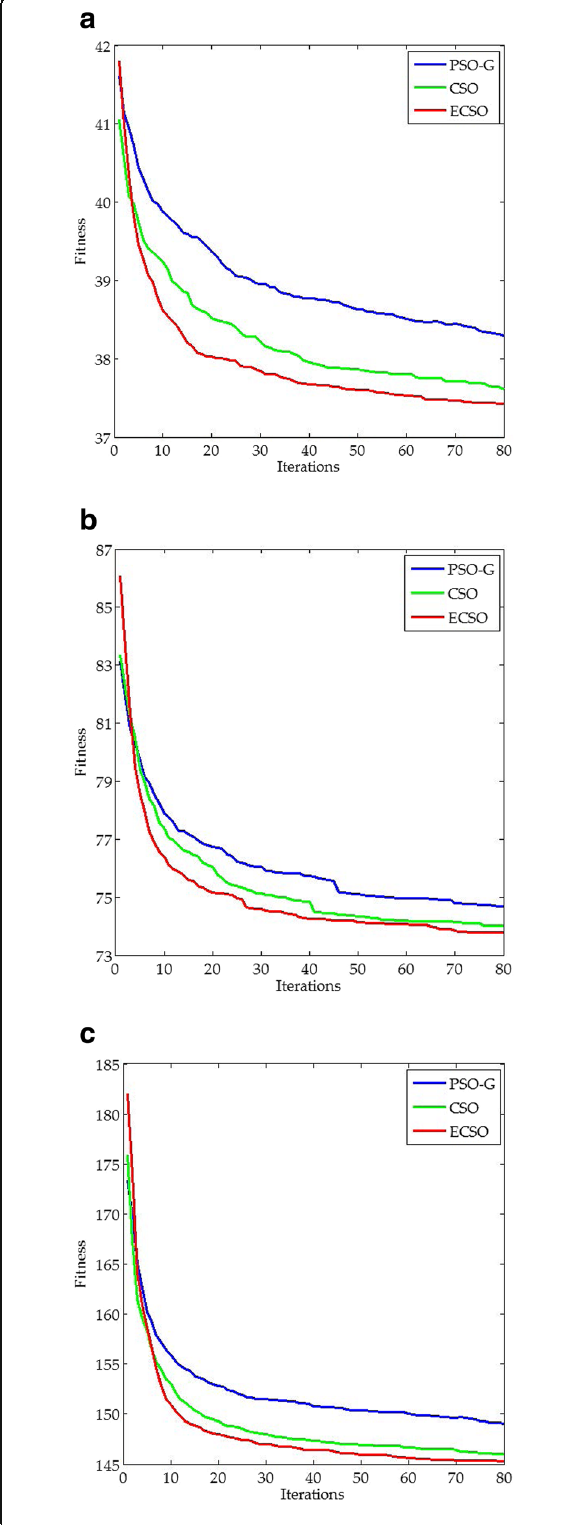
Fig. 2 Convergence process of the three approaches for solving different instances. a instance K32. b instance K64. c instance K128. Compares the performance of three approaches in terms of aggressive nature, in which the blue curve stands for the PSO-G approach, the green curve stands for the CSO approach, and the red curve stands for the ECSO approach. The statistical data is achieved by 40 Monte Carlo runs and instances K32, K64, and K128 are chosen to test the flexibility of the proposed approach. It can be obviously observed that both the convergence rate and optimization precision of ECSO are better than those of PSO-G and